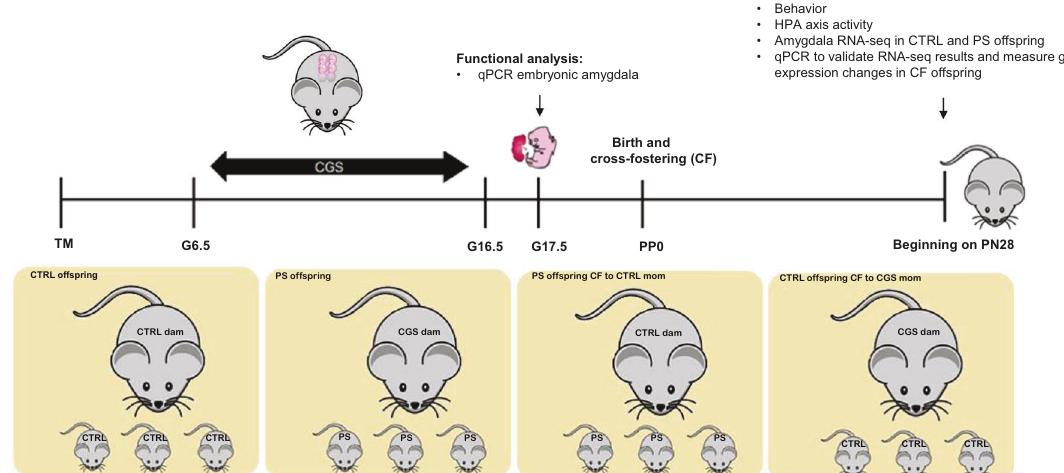
Fig. 1 Schematic outlining of the experimental paradigm. Psychosocial stress was performed from gestational day 6.5 (G6.5) to G17.5. Fetal amygdala qPCR was performed on G17.5. A separate subset of mice was cross-fostered (CF) at birth so as to generate four separate groups for our studies. Functional analysis was carried out in these four groups beginning at postnatal (PN) day 28, including behavior and neuroendocrine characterization. RNA-seq analysis was performed in control and PS offspring amygdala samples and a subset of differentially expressed genes from this analysis were measured in cross-fostered offspring amygdala samples via